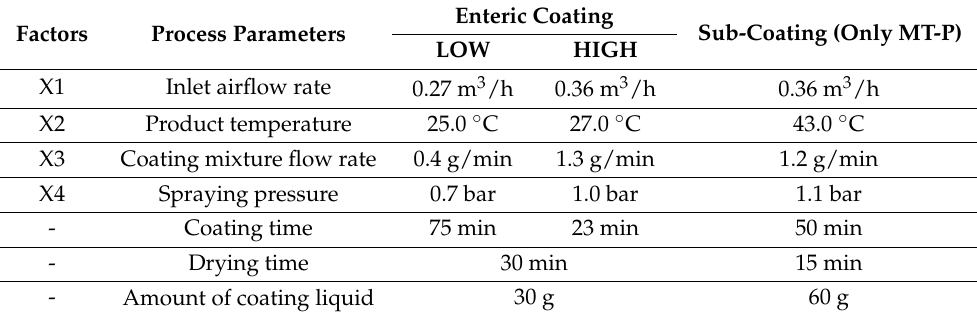
Table 2. Characteristics of the fluid bed coating process: sub-coating and enteric coating (tested on two levels).